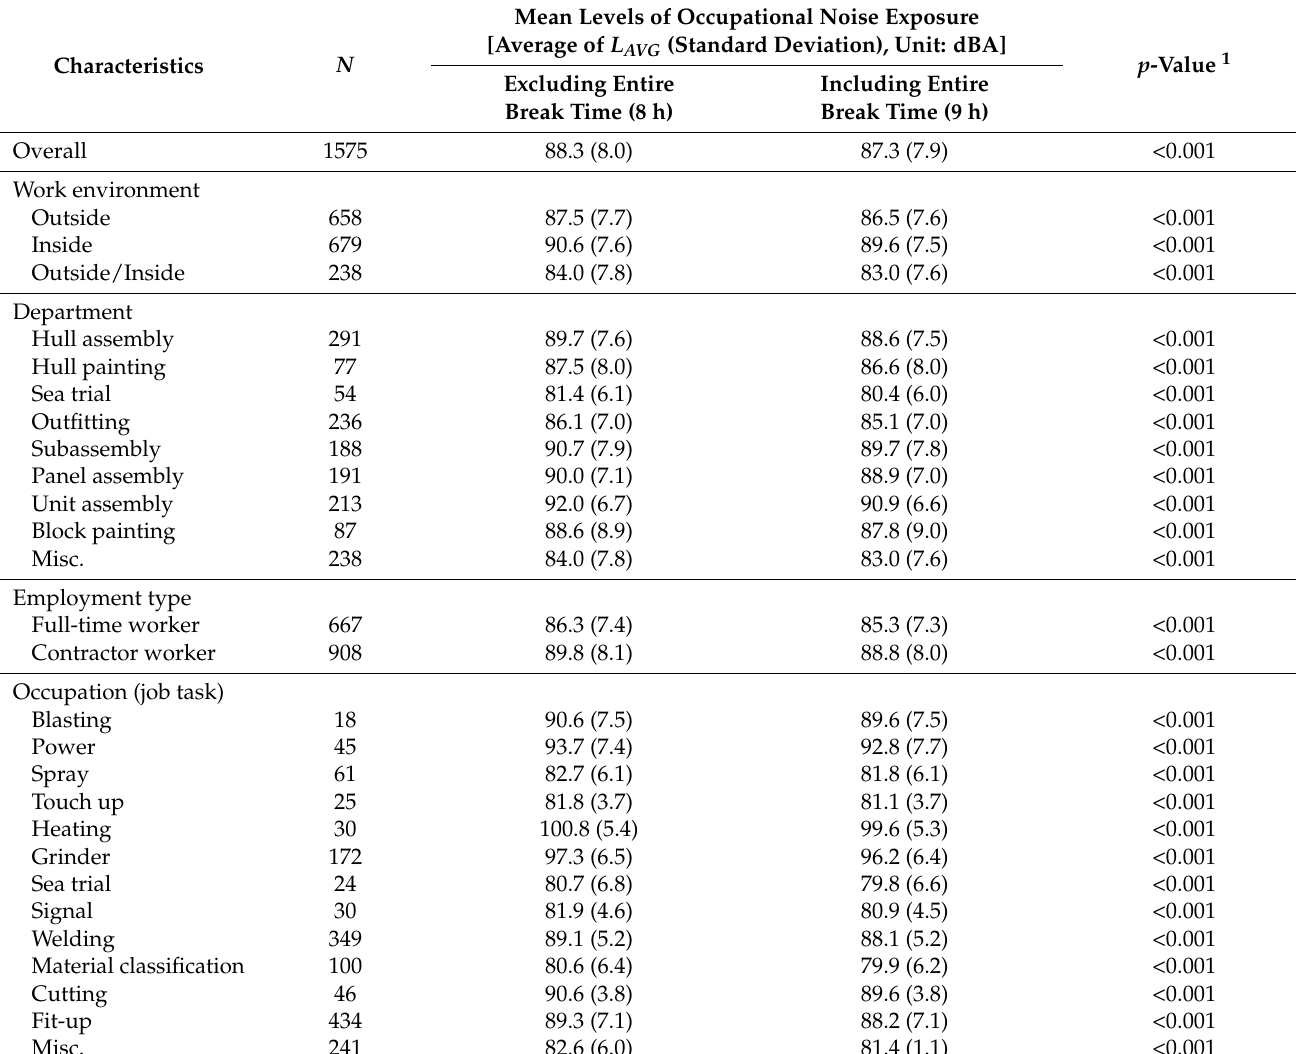
Table 4. Comparison of the mean levels of occupational noise exposure depending on inclusion or exclusion of the entire break periods.